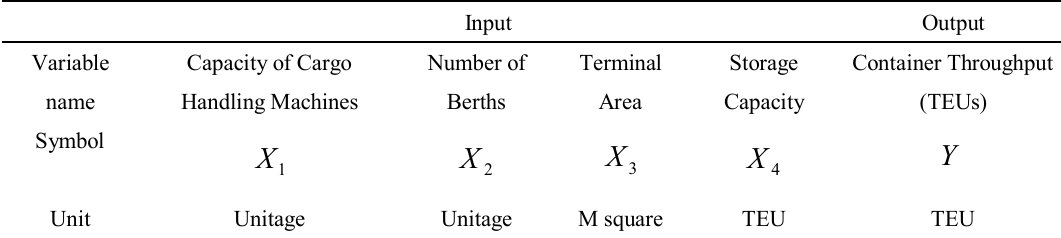
Table 2. List of Variables